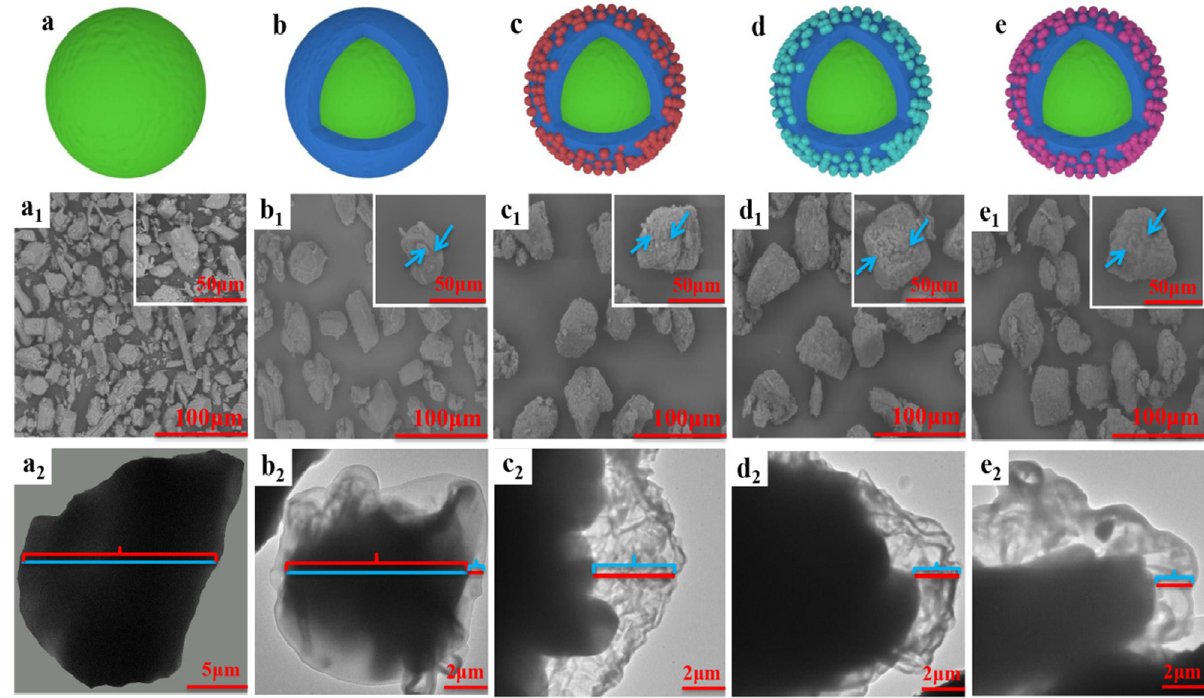
Figure 2: SEM and TEM images of the SB with coating layers. ( a ) SB, ( b ) EP@SB, ( c ) PA/EP@SB, ( d ) SA/EP@SB, ( e )